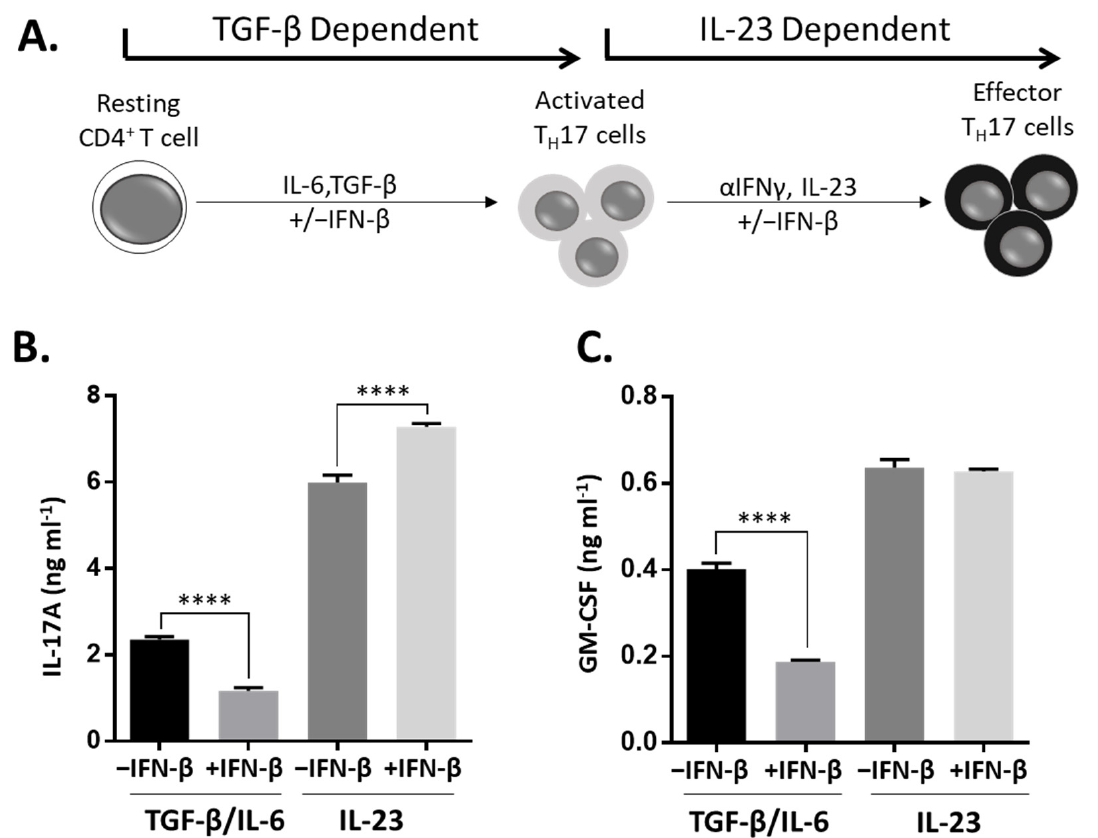
Figure 4. Impact of IFN- β on cytokine production during TGF- β -dependent and IL-23-dependent TH17 differentiation. Spleen and lymph node cells from healthy C57BL/6J were depleted of CD8+ cells and differentiated in the culturing scheme depicted in ( A ). For TGF- β -dependent TH17 differentiation, cells were stimulated with anti-CD3, anti-CD28, IL-6, TGF- β ± IFN- β . For IL-23-dependent TH17 differentiation, cells were stimulated with anti-CD3, anti-CD28, IL-23, anti-IFN- γ ± IFN- β . The concentrations of ( B ) IL-17A and ( C ) GM-CSF secreted were determined by ELISA following early and late differentiation. Statistical analysis was performed using one-way ANOVAs. p values < 0.05 were considered significant (**** indicates p < 0.0001). Error bars indicate s.e.m.